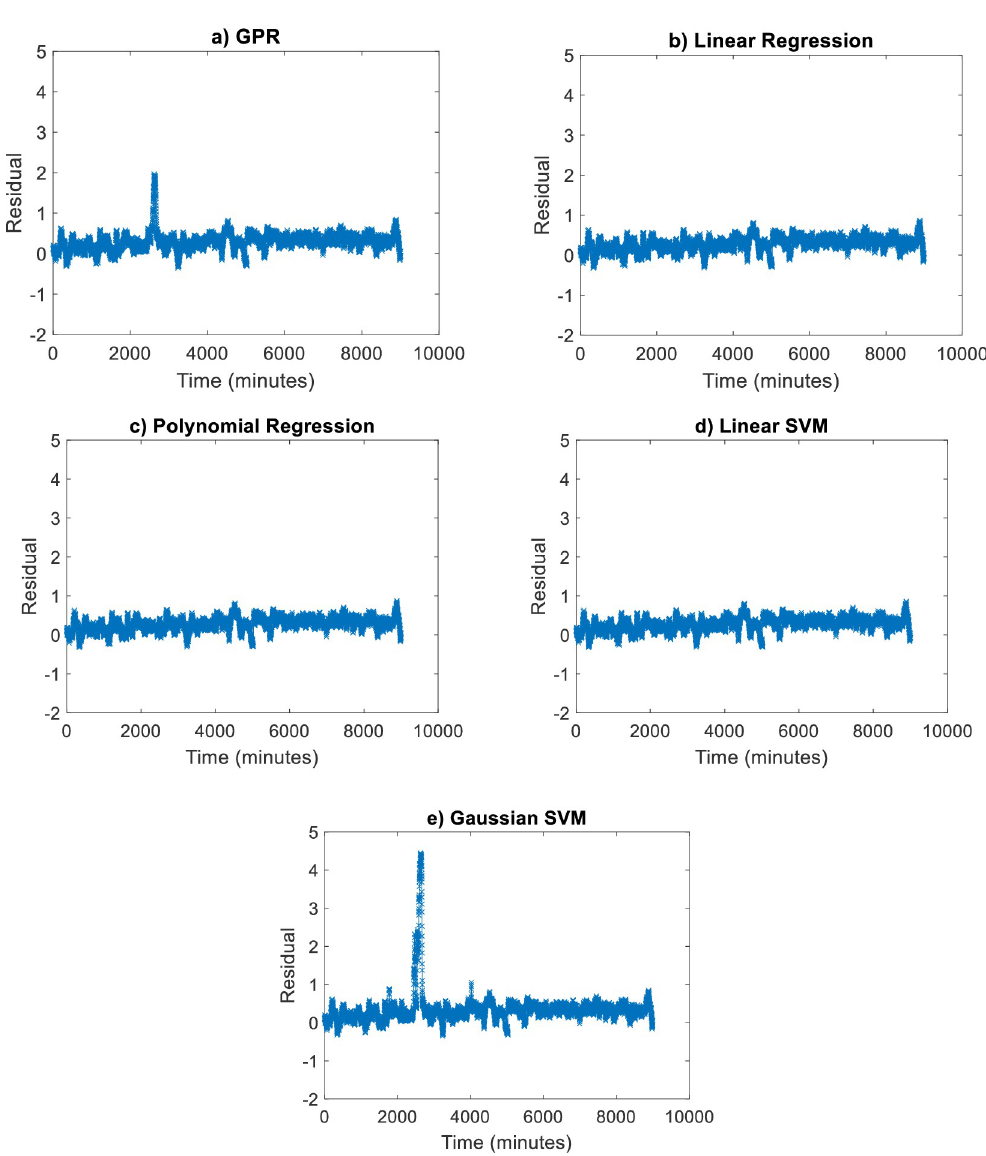
Fig 11. (a)-(e). Residual plot of all estimation techniques for T